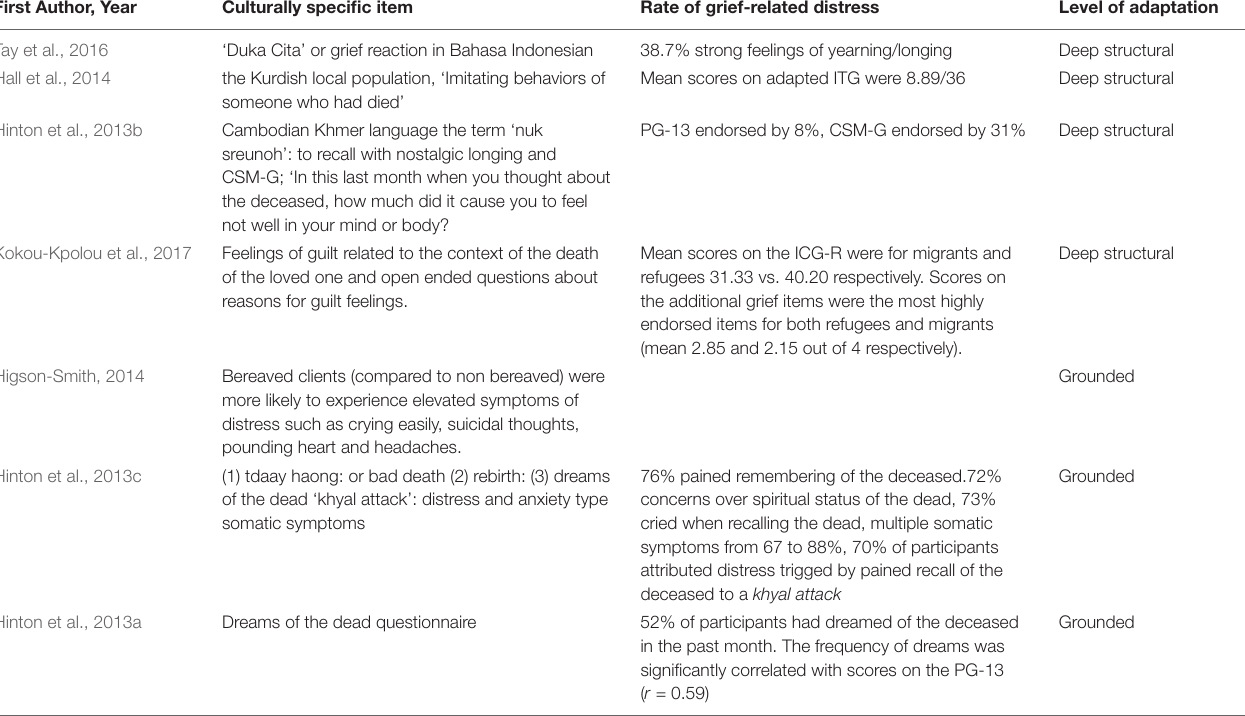
TABLE 2 | Cultural specific items revealed from emic deep structural and grounded